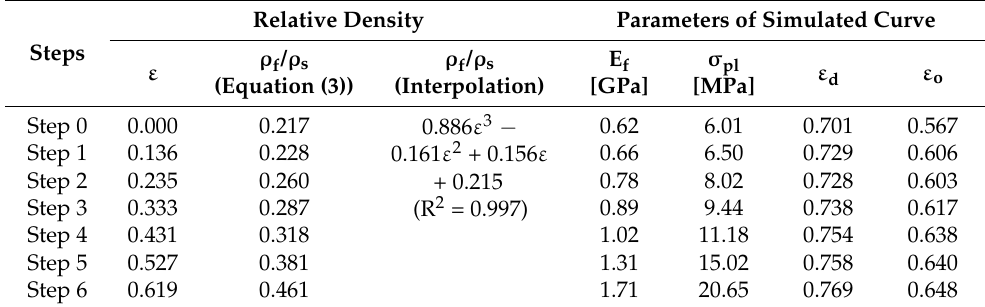
Table 3. Correlation model: Relative density and parameters of simulated compression curve (0.4% TiH 2 foam).